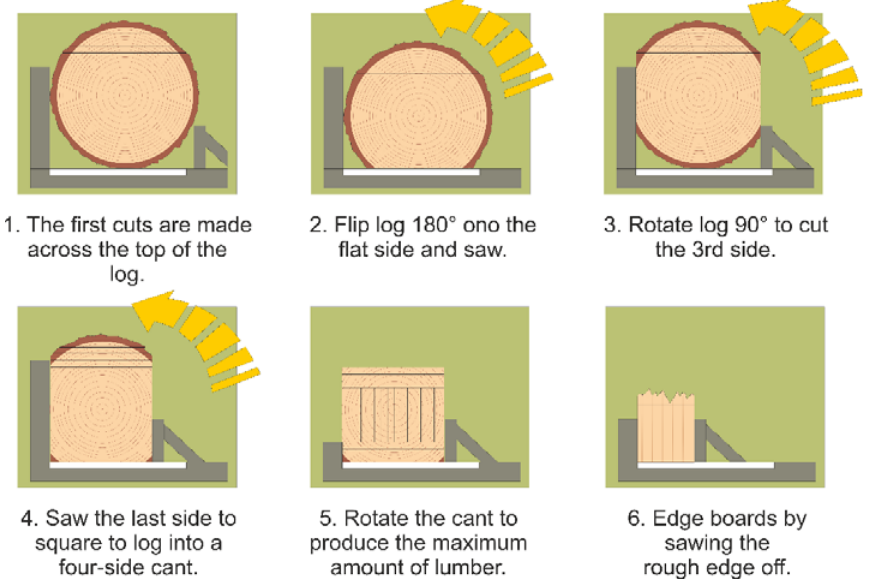
Figure 2. Log cutting steps.